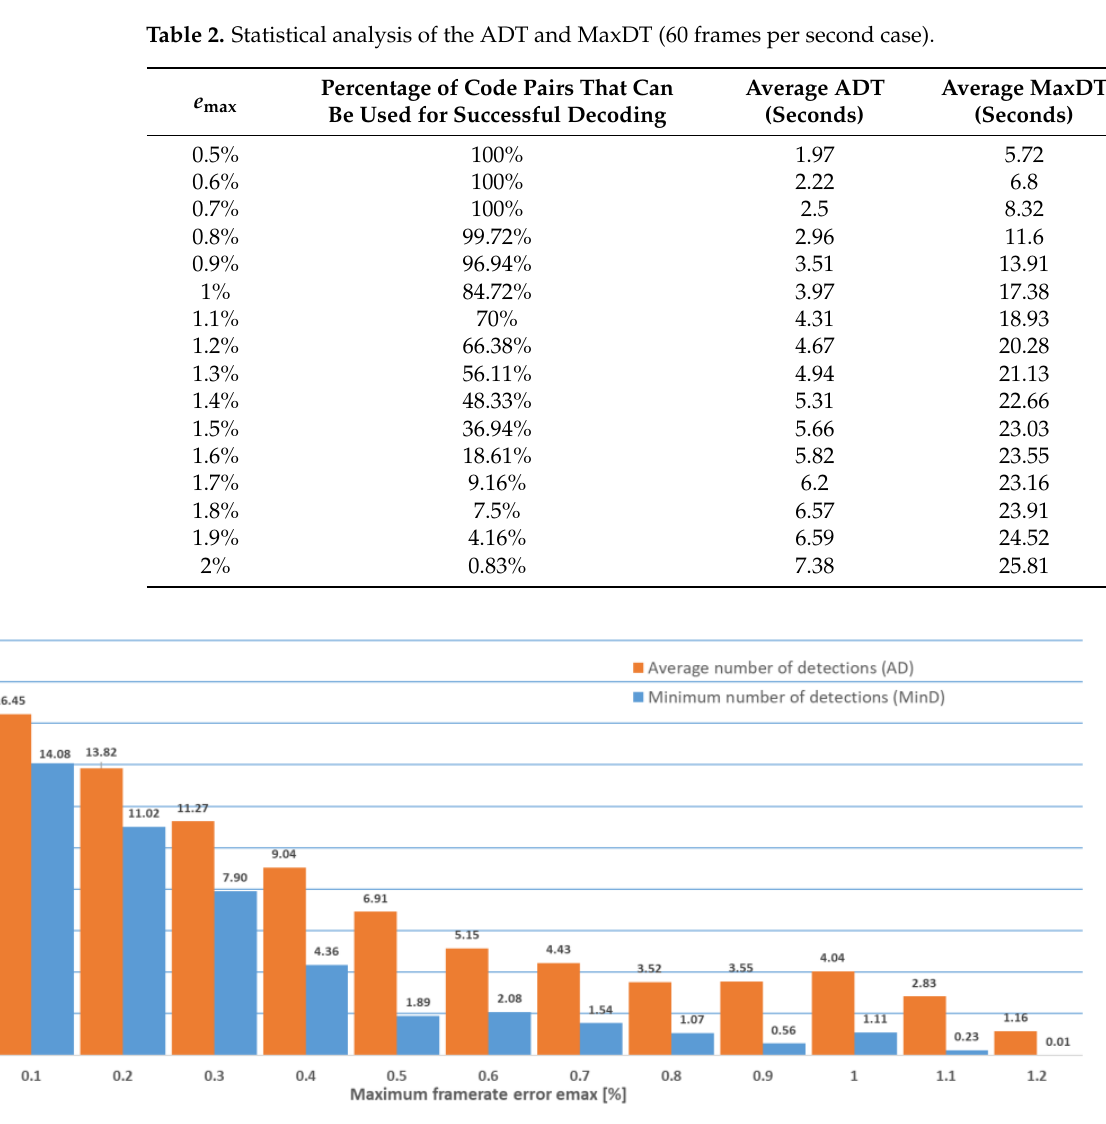
Figure 7. Minimum number of detections (MinD) and average number of detections (AD) out of a maximum of 20 (30 frames per second case). Table 3. Statistical analysis of the ADT and MaxDT (30 frames per second